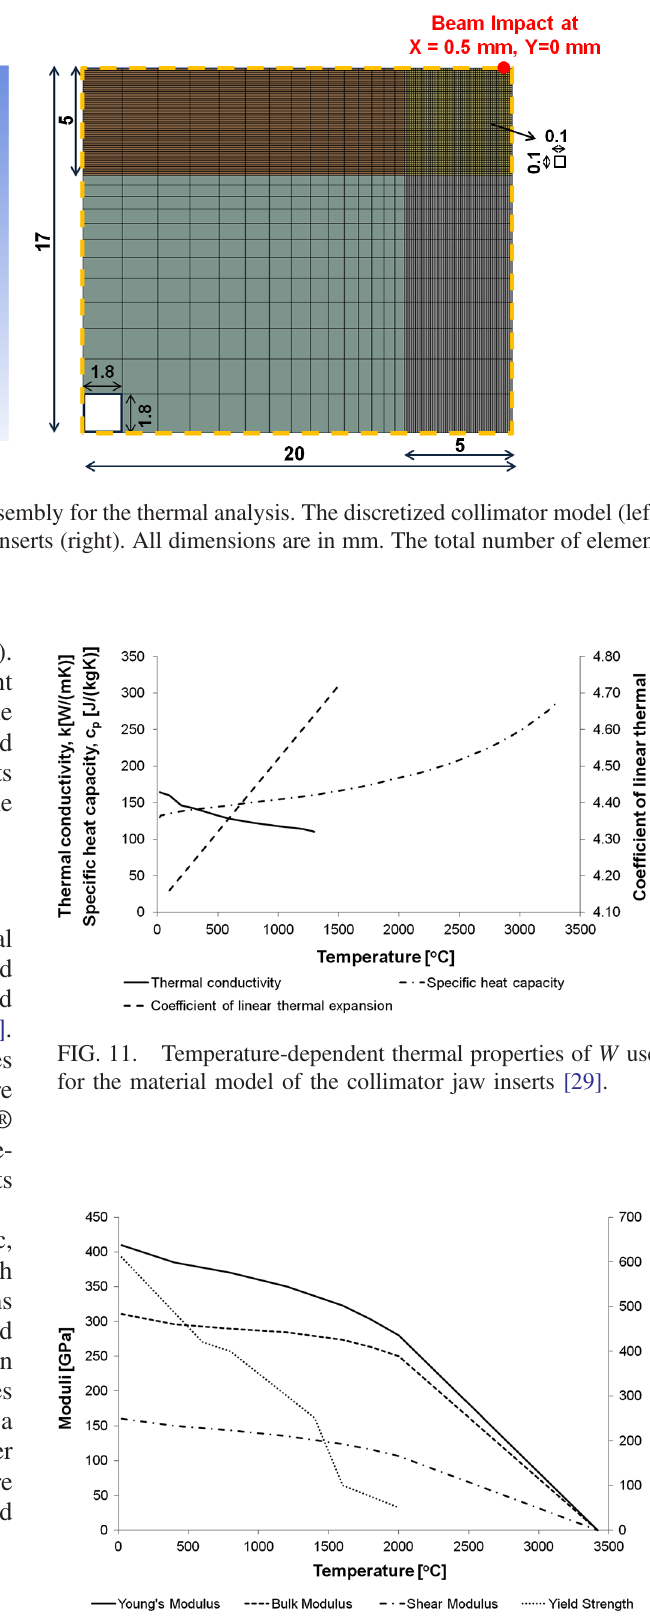
FIG. 12. Temperature-dependent structural properties of W used for the material model of the collimator jaw inserts